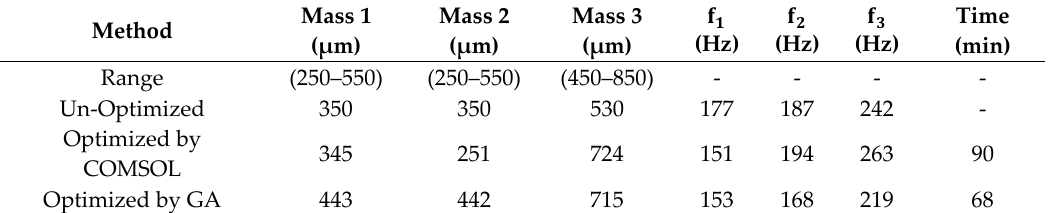
Table 1. The multimode resonant frequencies for the un-optimized and the optimized proof masses.